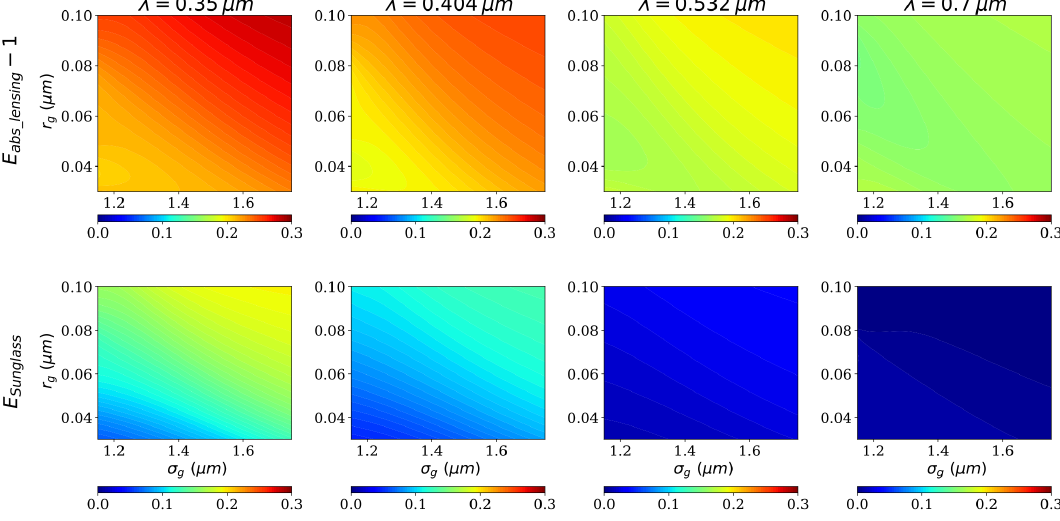
Figure 5. Similar to Fig. 4, but for E abs_lensing and E Sunglass